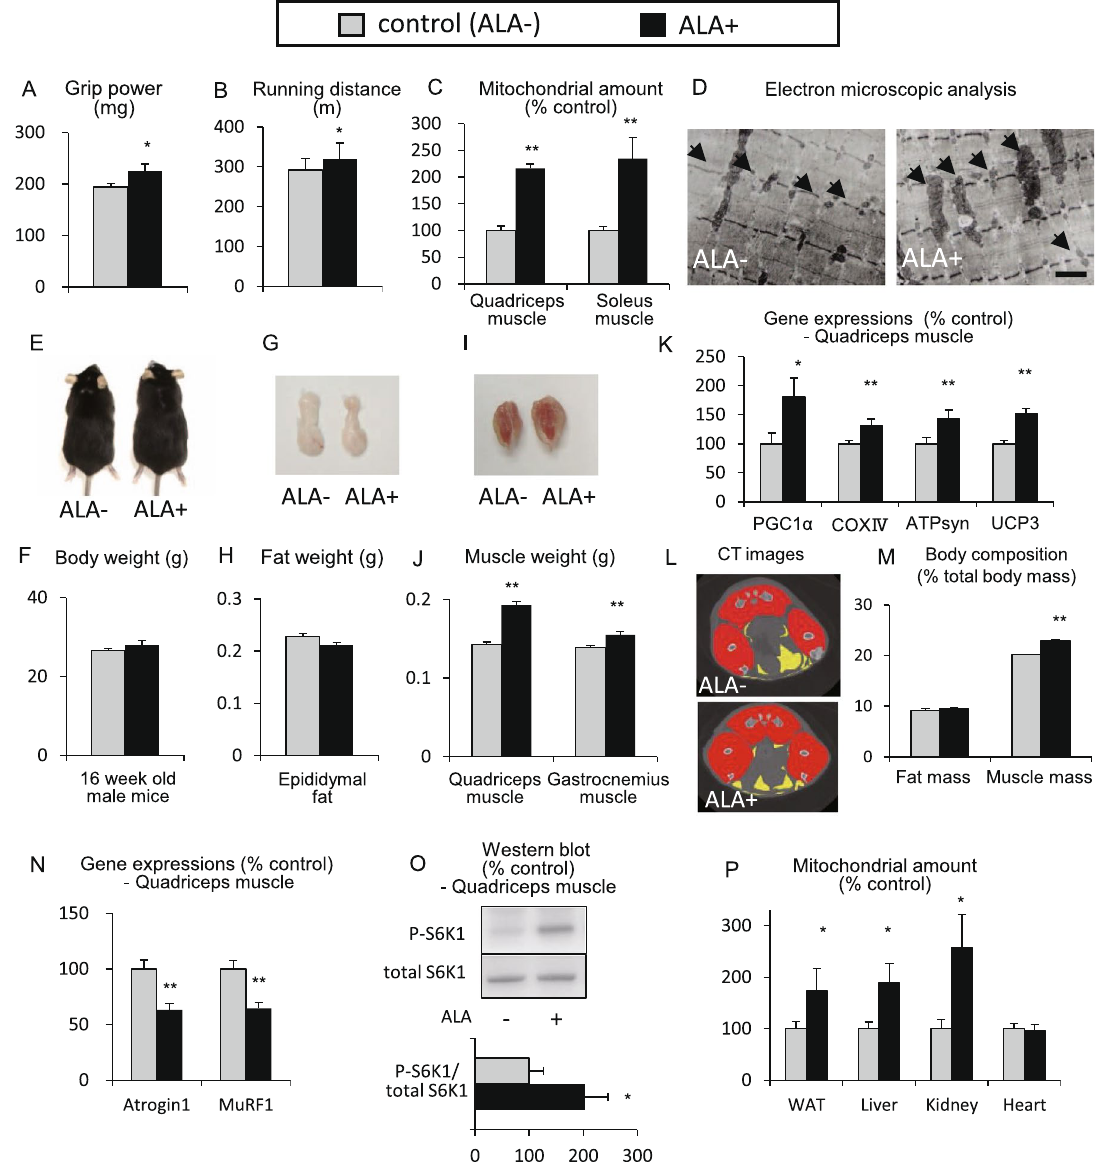
Figure 1. 5-aminolevulinic acid improves physical performance by activating mitochondria and increasing muscle mass. To investigate the effects of ALA on muscle mitochondria and physical performance, C57BL/6 mice were fed with an ALA-containing diet (0.03% ALA) for 8 weeks from 8 weeks of age. Control mice (ALA − ) and ALA- treated mice (ALA + ) were examined. ( A ) Grip power at 16 weeks (16 W) of age as an index of muscle strength, ( B ) Running distance at 16 W as an index of endurance, ( C ) Mitochondrial amount in the quadriceps muscle and soleus muscle, estimated from mitochondrial DNA copy number, ( D ) Electron microscopic analysis of the quadriceps muscle. Scale bar = 1 µ m, ( E , G and I ) Macroscopic view of the mice, epididymal fat and gastrocnemius muscle with soleus muscle, ( F , H and J ) The body weight, weight of the epididymal fat, and weight of the quadriceps and gastrocnemius muscle, ( K ) expression of mitochondria-related genes estimated by quantitative PCR analysis (PGC1 α , COXIV, ATPsyn and UCP3), ( L ) Micro-CT images at the level of the maximal thigh circumference of the mice. The red part is the muscle, the yellow part is the fat, ( M ) The body composition of the ALA-treated mice at the total body level. The ratios of fat mass and muscle mass to total body volume estimated from the micro-CT images are shown; N = 4 in each group, ( N ) expression of muscle degradation-related genes estimated by quantitative PCR analysis (Atrogin1, MuRF1), ( O ) Western blots of P-S6K1 and total S6K1 (upper) and densitometry of the ratio of P-S6K1/total S6K1, as an index of S6K1 activity (lower). Full-length blots are included in the Supplementary Information, ( P ) Mitochondrial amount in various tissues (WAT, liver, kidney and heart). N = 8 in each group unless otherwise indicated. * P < 0.05, ** P < 0.01 versus control mice. ALA, 5-aminolevlinic acid; PGC1 α , peroxisome proliferator-activated receptor- coactivator 1; COXIV, cytochrome c oxidase subunit IV; ATPsyn, adenosine triphosphate synthase; UCP3, uncoupling protein 3; CT, computed tomography; Murf1, muscle specific ring finger protein 1; P-S6K1, phosphorylated S6 kinase1; WAT, white adipose